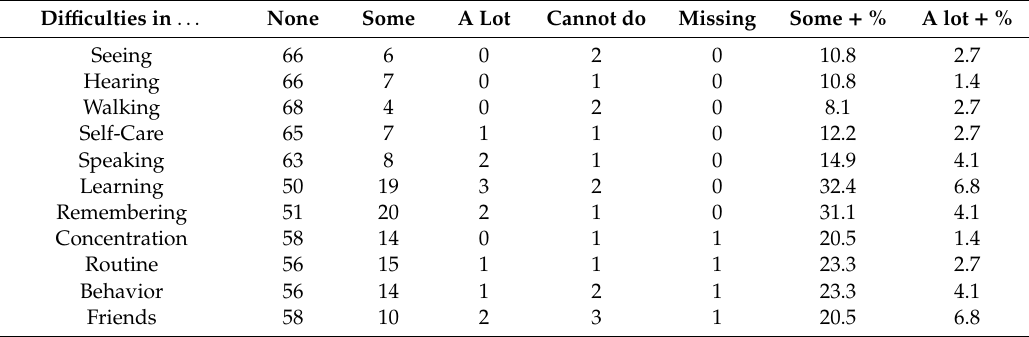
Table 3. Distribution of reporting di ffi culties from retest survey and prevalence using the cut-points based at some di ffi culties and a lot of di ffi culties.